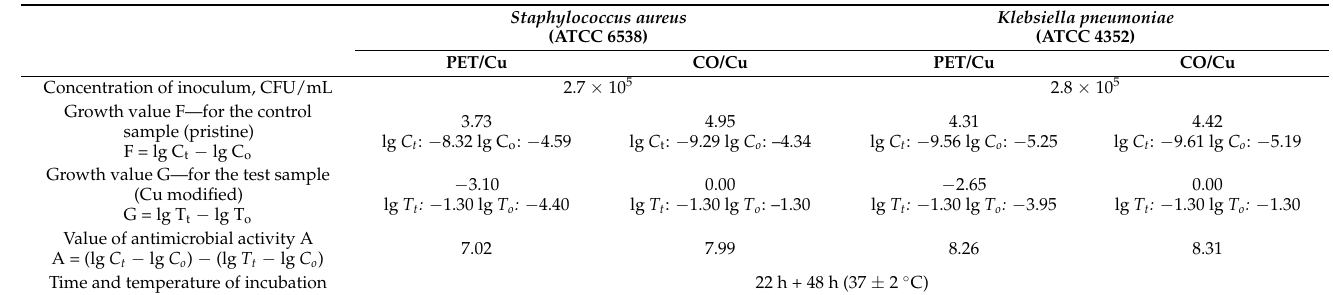
Table 5. The results of antibacterial activity.